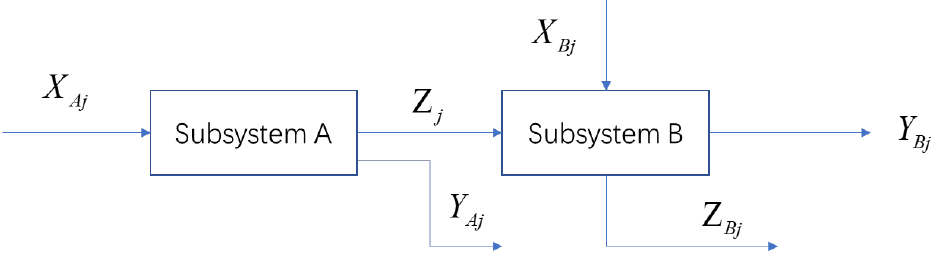
Figure 1. The structure of DMU with the two-stage production system.